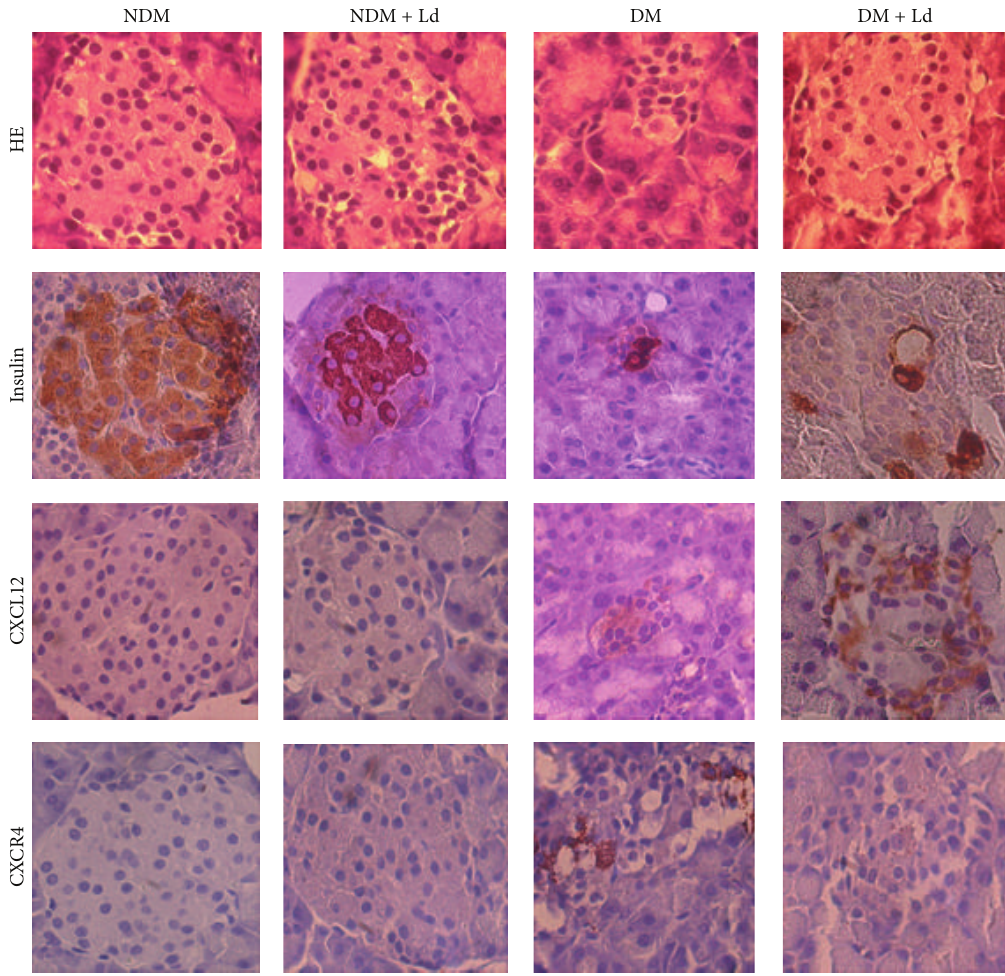
Figure 3: The effect of administration of the L. deterrimus extract on histological changes and immunohistochemical localization of insulin and CXCL12 in pancreatic islets. HE: hematoxylin and eosin staining of pancreatic sections; light photomicrographs of insulin, CXCL12, and CXCR4 immunohistochemical staining of pancreatic sections within islets (magnification 40x). NDM: control rats; NDM + Ld: control rats treated daily with L. deterrimus extract for four weeks; DM: STZ-induced diabetic rats; DM + Ld: STZ-induced diabetic rats treated with L. deterrimus extract for four